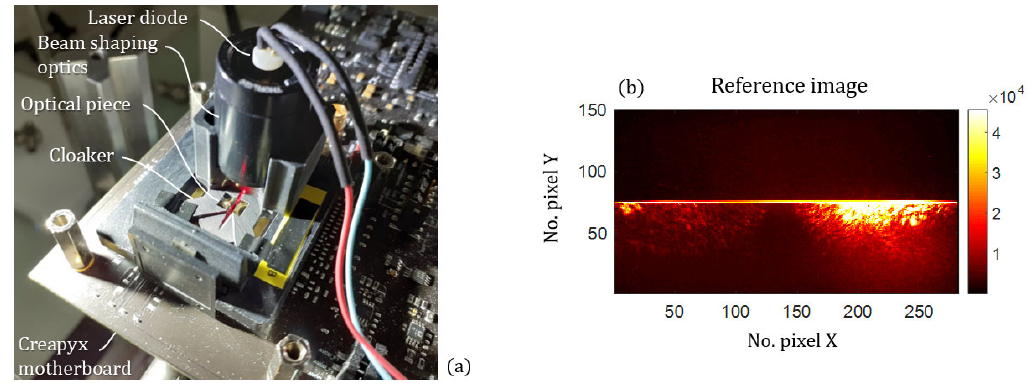
Figure 14. ( a ) Photography of the characterization setup. ( b ) Reference image without